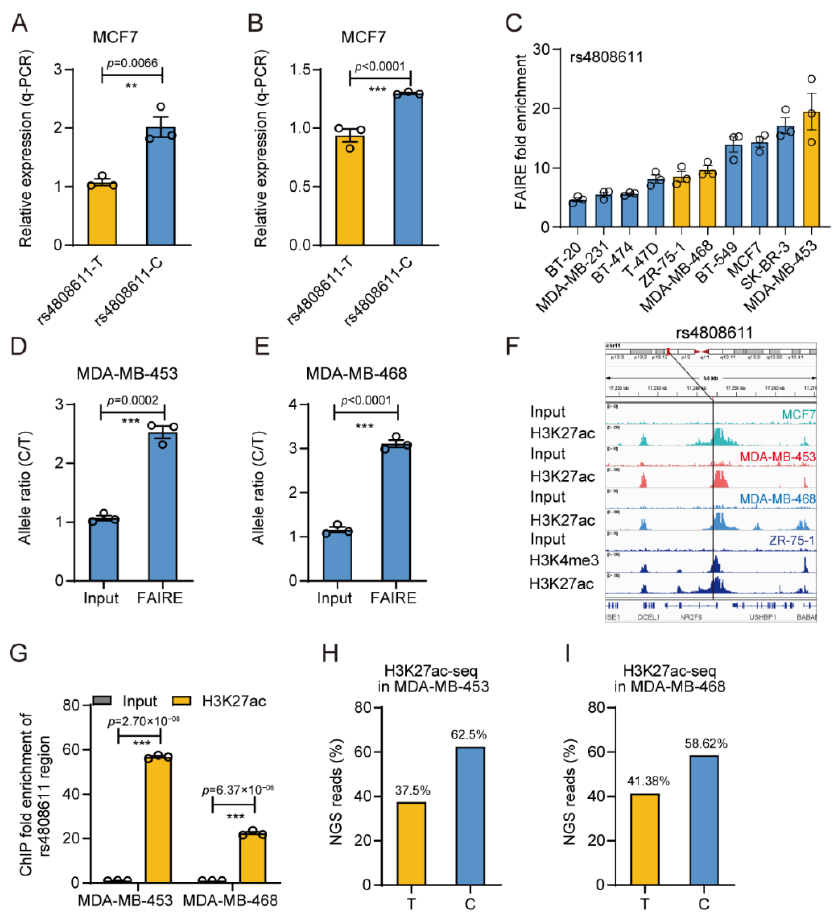
Figure 5. The gene regulatory activity analysis of rs4808611. ( A ) Reporter gene expression level of the rs4808611-centered 55bp region in the DiR-qPCR assay in MCF7 cells. Mean ± SD of three independent experiments. ** p < 0.01, two-tailed Student’s t -test. ( B ) Reporter gene expression level of the rs4808611-centered 733bp region in the DiR-qPCR assay in MCF7 cells. Mean ± SD of three independent experiments. *** p < 0.001, two-tailed Student’s t -test. ( C ) FAIRE-qPCR analysis of the regulatory SNP rs4808611 in ten breast cancer cells, including BT-20, MDA-MB-231, BT-474, T-47D, ZR-75-1, MDA-MB-468, BT-549, MCF7, SK-BR-3 and MDA-MB-453. The three cell lines heterozygous for rs4808611 are highlighted in orange. Mean ± SD of three independent experiments. ( D ) Allele- specific enrichment of rs4808611 region in FAIRE DNA determined by AS-qPCR in MDA-MB-453 cells. Mean ± SD of three independent experiments. *** p < 0.001, two-tailed Student’s t -test. ( E ) Allele-specific enrichment of rs4808611 site in FAIRE DNA determined by AS-qPCR in MDA-MB-468 cells. Mean ± SD of three independent experiments. *** p < 0.001, two-tailed Student’s t -test. ( F ) Chromatin structure and feature visualization for a 54kb rs4808611-centered region, including ChIP- seq signal intensity tracks of H3K27ac ChIP-seq experiments in MCF7 (green), MDA-MB-453 (red), MDA-MB-468 (blue) and ZR-75-1 (dark blue) cells and H3K4me3 ChIP-seq experiment in ZR-75-1 (dark blue) cells. Chromatin structure (top) and gene information (bottom) are shown, with the SNP position marked by a vertical line. ( G ) ChIP-qPCR analysis of the rs4808611 region in H3K27ac ChIP DNA in MCF7 cells. Mean ± SD of three technical replicates. *** p < 0.001, two-tailed Student’s t -test. ( H ) NGS read counts of the rs4808611 alleles in H3K27ac ChIP-seq analysis in the MDA-MB-453 cell line. ( I ) NGS read counts of the rs4808611 alleles in H3K27ac ChIP-seq analysis in the MDA-MB-468 cell